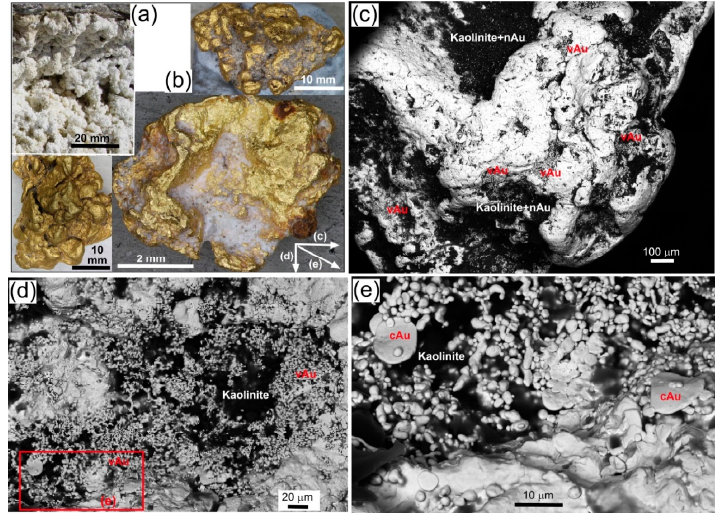
Figure 5. Mineralogical features of the Chapman Road saline site (Table 1; Figure 1a). ( a ) Evaporative encrustations on outcrop, dominated by halite, bloedite, calcite, and gypsum; ( b ) Three large gold nuggets from Late Pleistocene fan gravels resting on the regional unconformity; ( c ) SEM backscatter electron image of a portion of the indicated nugget in a, with abundant vermiform authigenic gold (vAu); ( d , e ) Closer views of surface of nugget in ( c ), with vermiform and crystalline (cAu) authigenic gold.